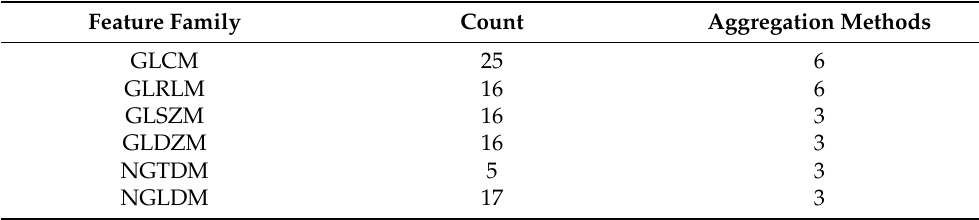
Table 2. Feature families and corresponding feature number and aggregation